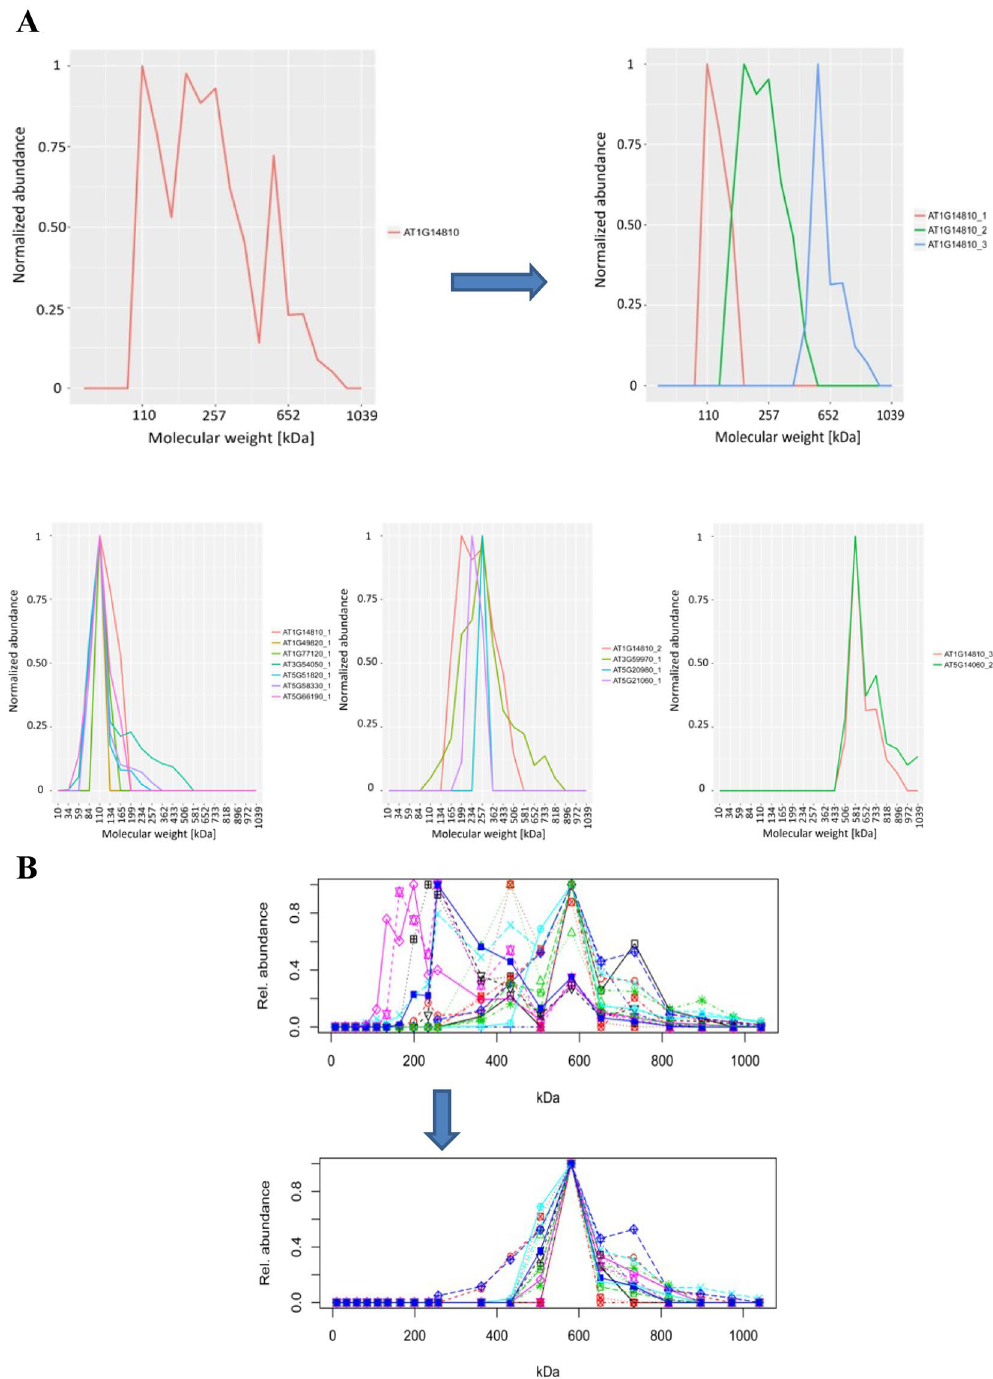
Figure 5. The importance of protein profile deconvolution for protein complex identification. The migration profile of aspartate semialdehyde dehydrogenase was deconvoluted into three distinct peaks. ( A ) Each of the deconvoluted peaks was found in a different cluster following a hierarchical clustering analysis. The profiles of proteins found in the same cluster, which also function in the same cellular process as aspartate semialdehyde dehydrogenase were visually represented. From the left: oxidation-reduction process (AT1G14810_1), methionine biosynthetic process (AT1G14810_2), lysine biosynthetic process via diaminopimelate (AT1G14810_3). ( B ) To determine the impact of deconvolution on very complex protein profiles, an elution profile of a number of proteins from the pentose-phosphate pathway is shown. In the upper panel no deconvolution is applied, and as a result hierarchical clustering could not be used to identify the proteins as being in a complex. In the lower panel deconvolution was performed, which provided clearly defined peaks that could be used in the same hierarchical clustering approach to identify a complex of 16